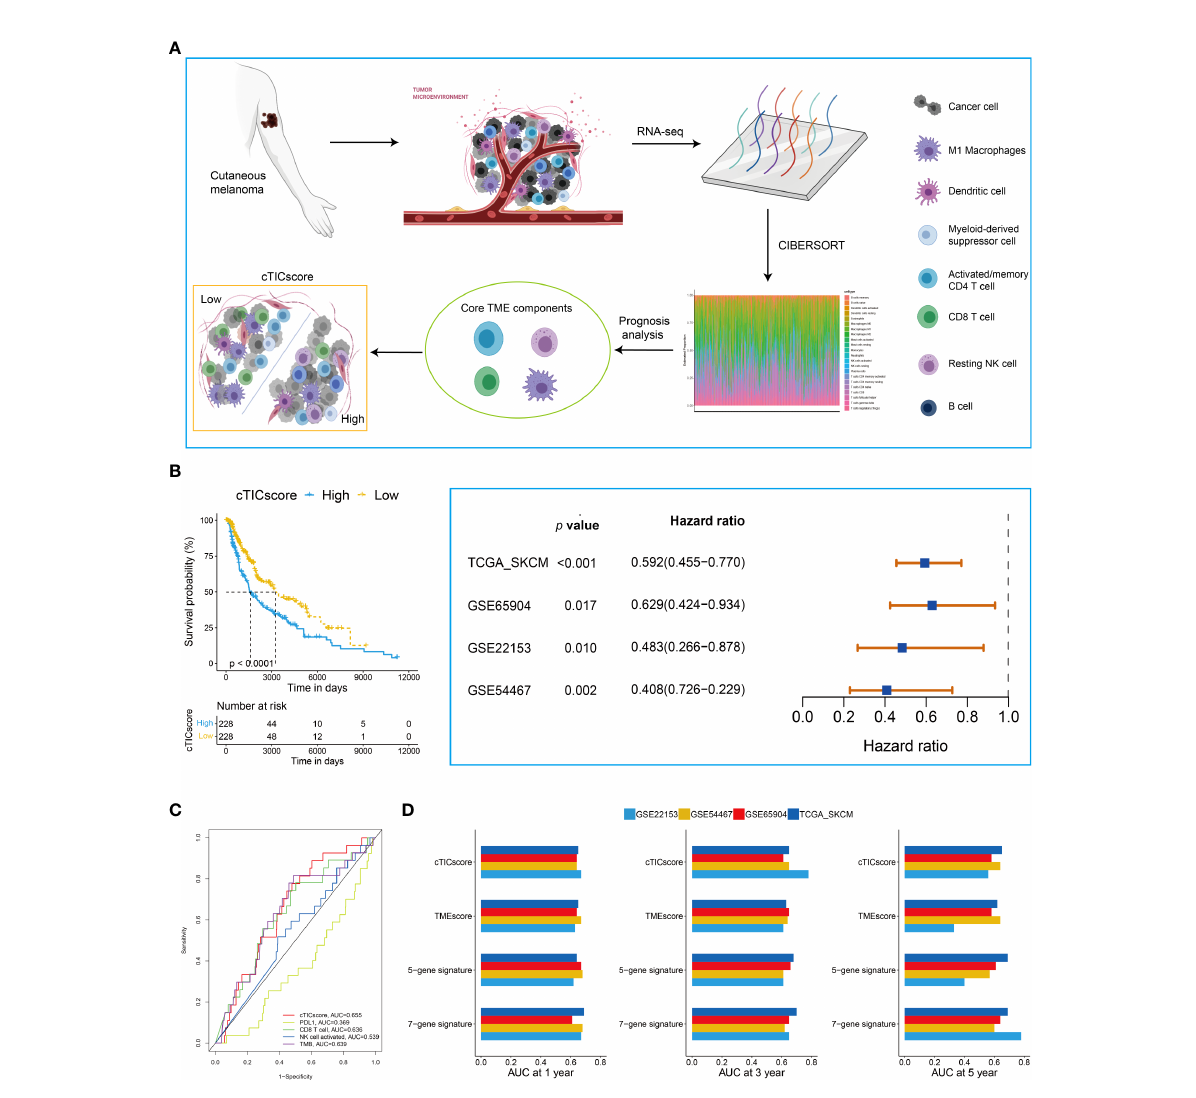
FIGURE 1 Identi fi cation of CM subtypes with distinct prognoses based on the cTICscore. (A) Illustration for the construction of the cTICscore in CM. (B) cTICscore-based CM subtypes exhibited distinct prognoses. (C) Time-dependent ROC curves for the cTICscore and other predictors. (D) AUC of the time-dependent ROC curves for the cTICscore, TMEscore, the fi ve-gene signature and the seven-gene